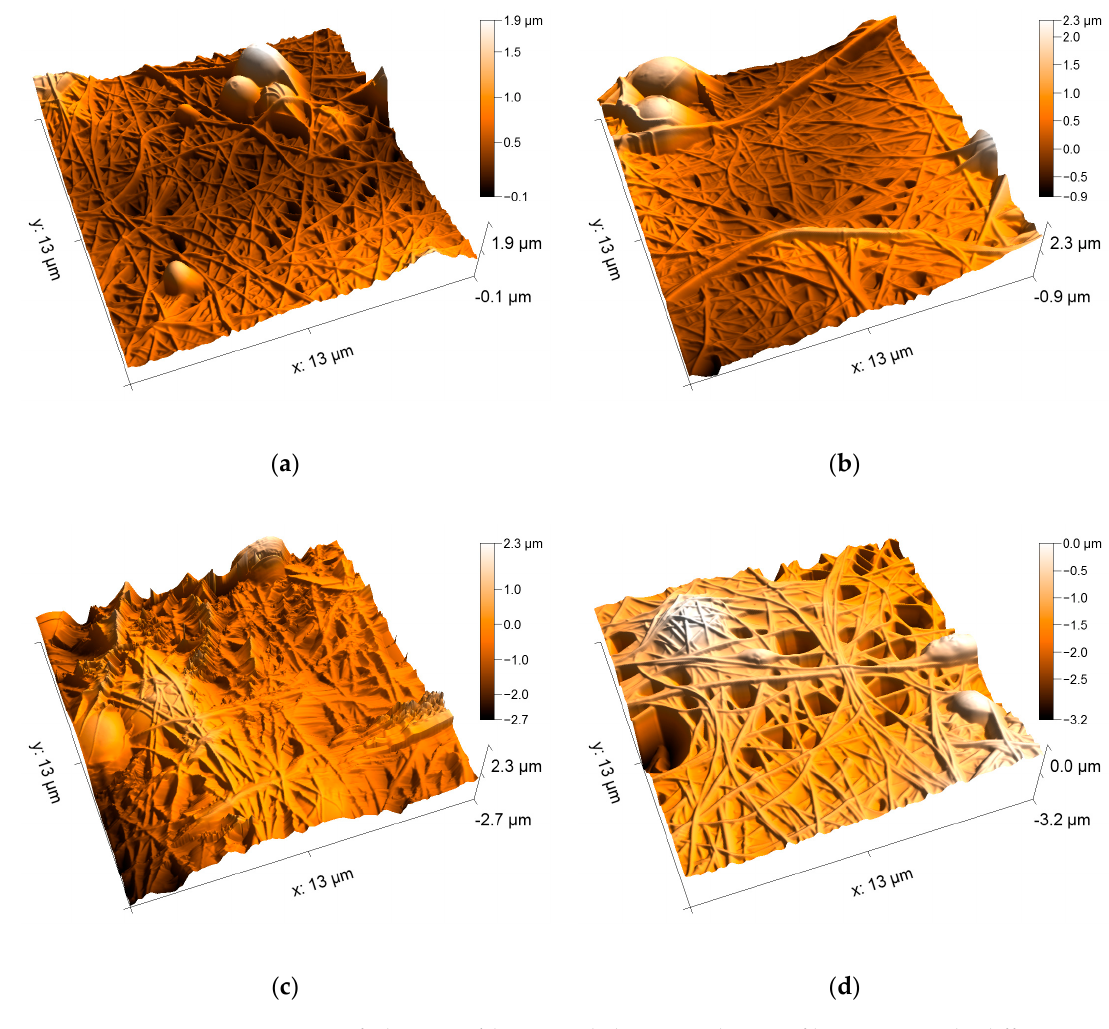
Figure 9. AFM images of the PAN/diiron nickel tetraoxide nanofiber mats with different polymer:nanoparticle weight ratios: ( a ) 1:0.38; ( b ) 1:0.79; ( c ) 1:1.25; ( d ) 1:1.8.